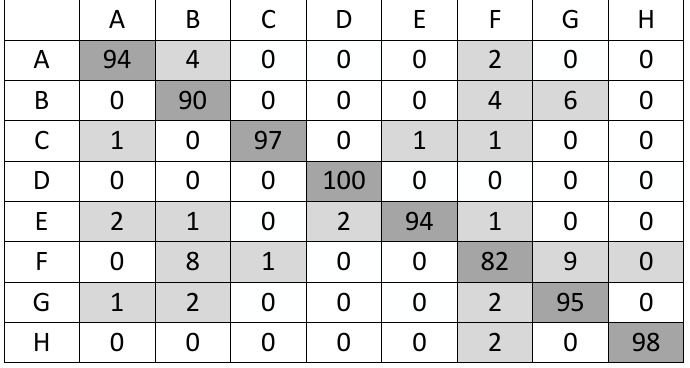
Figure 10. Confusion matrix for the system at the SNR of −8 dB.